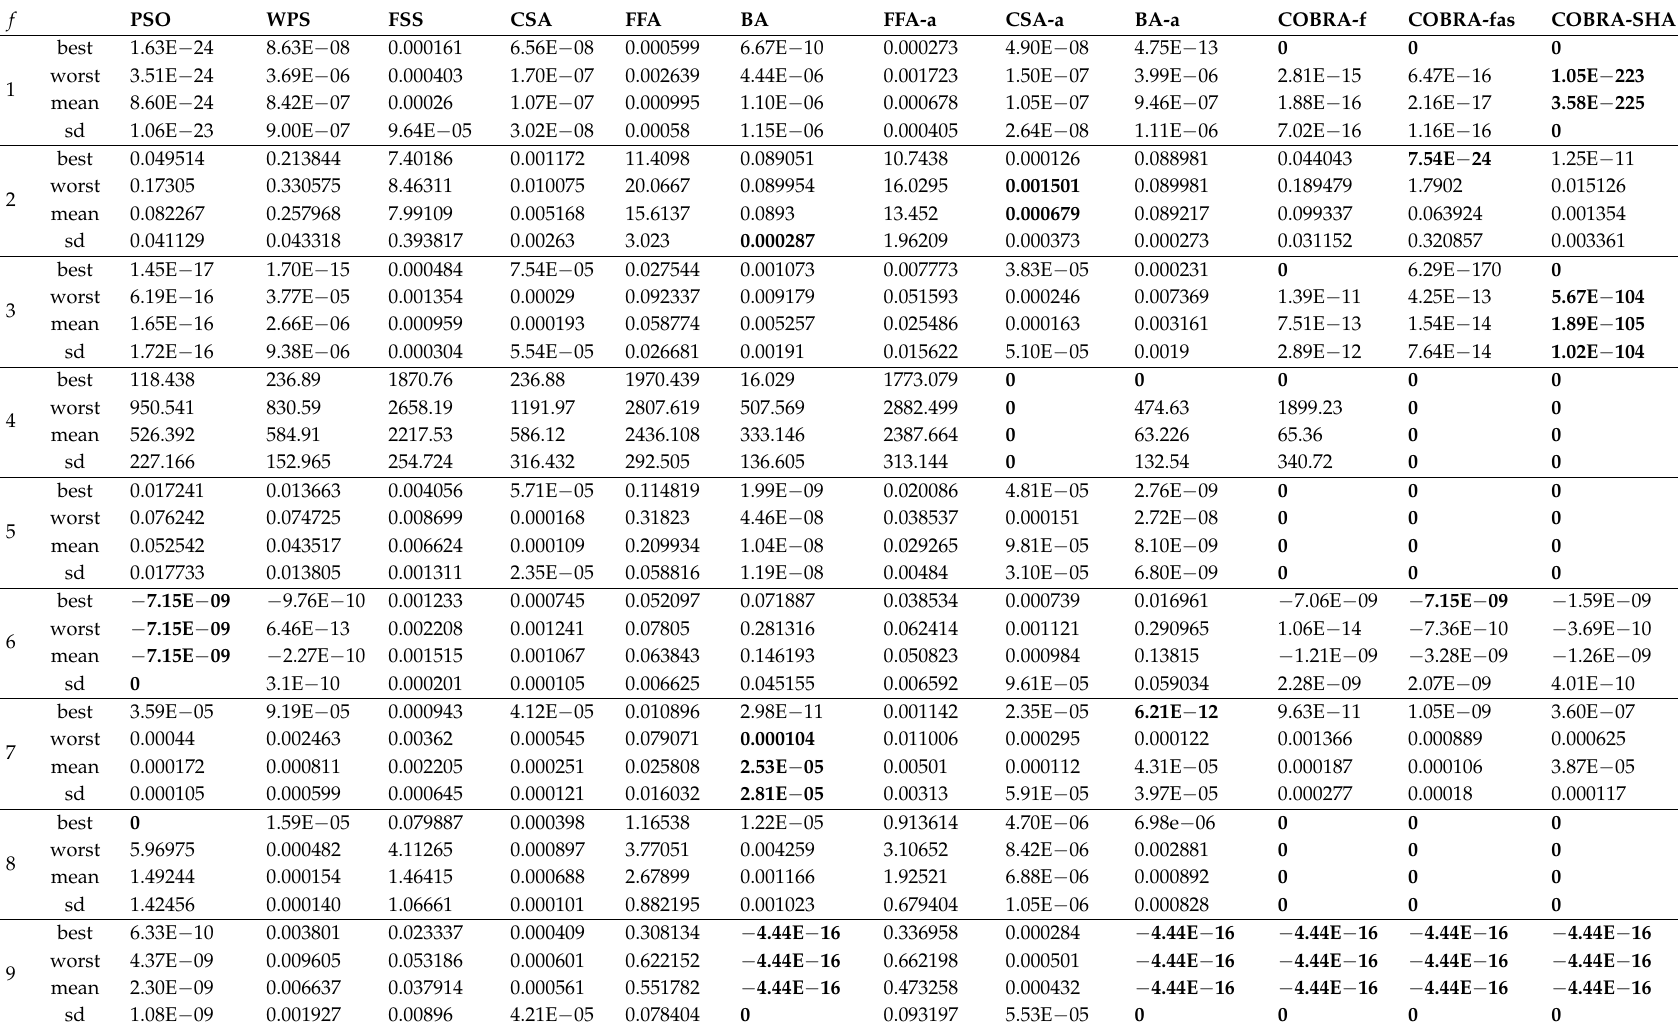
Table 4. Experimental results for 10-dimensional functions from